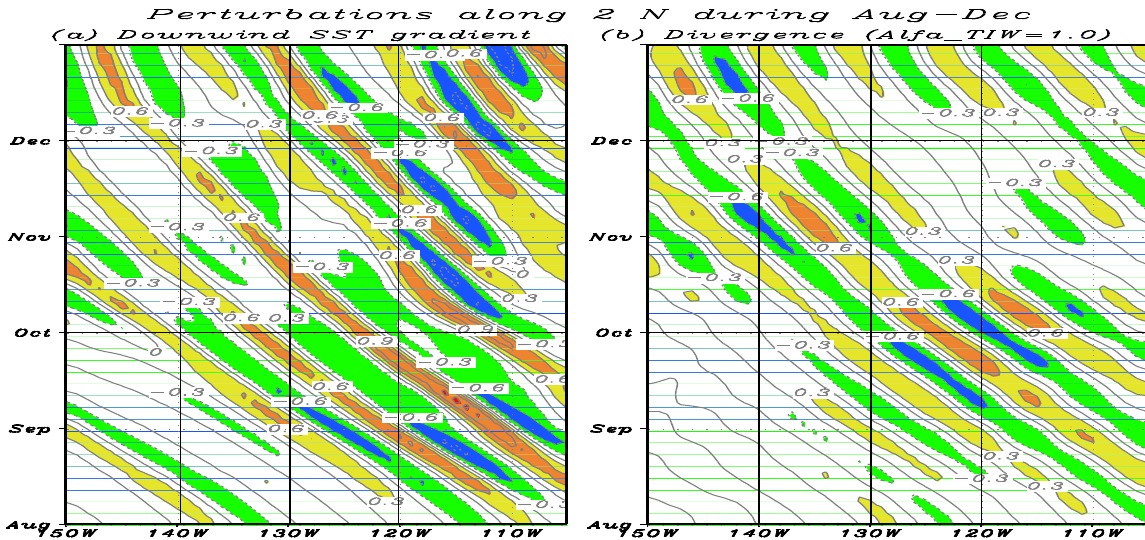
Figure 13. Time-longitude sections along 2°N during August-December for the (left panels) zonal-high-pass filtered downwind component of the SST gradient, and (right panels) wind stress divergence, estimated from the feedback runs with α (( c , d )), respectively. The calculations are made from daily SST data in year 13. The contour is 0.3 °C per 100 km in (a,c), and is 0.3 N∙m −2 per 10 4 km in